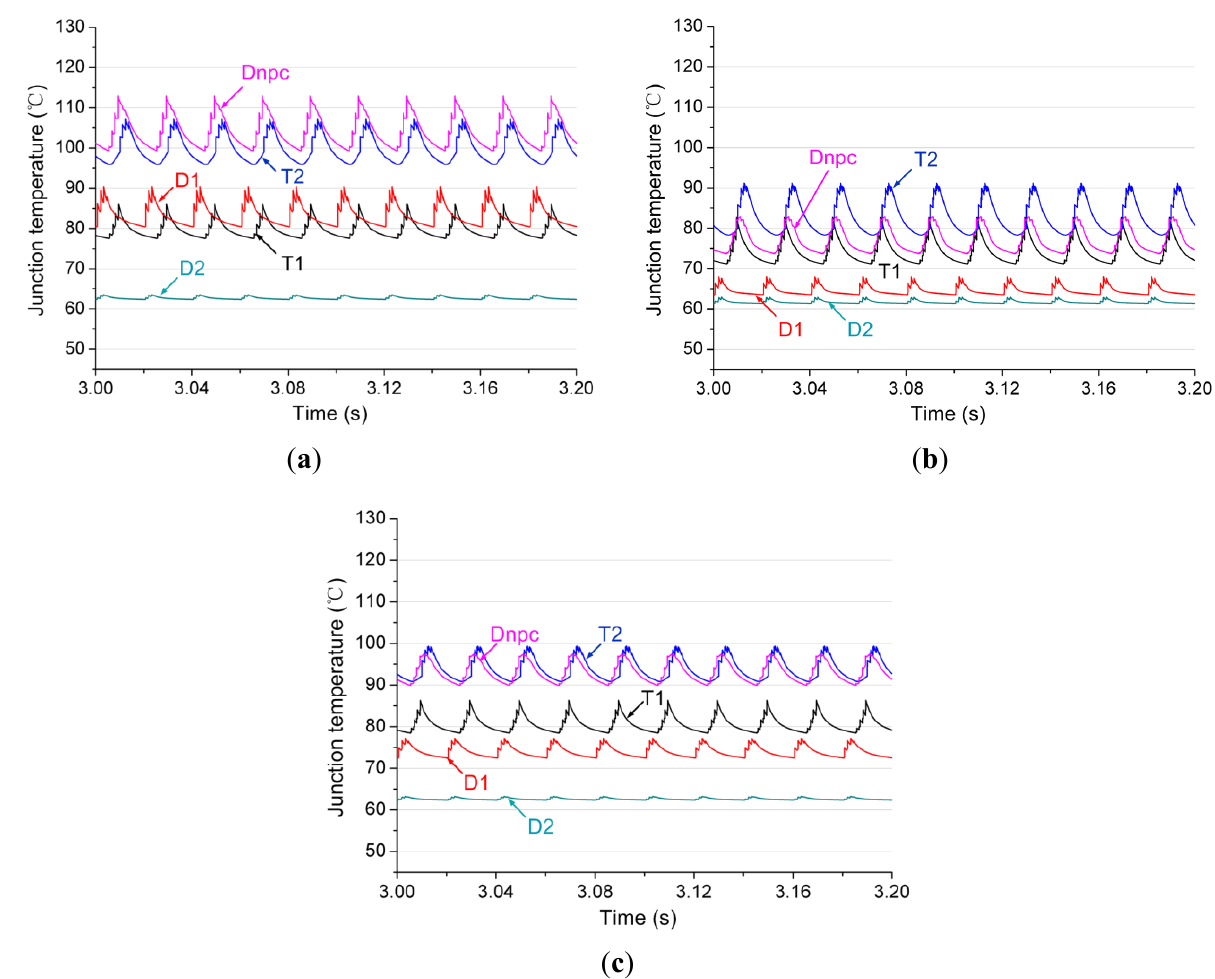
Figure 15. Thermal cycling of the 3L-NPC inverter with different switching device solutions during Low-Voltage-Ride-Through operation condition in Figure 13. ( a ) IGCT presspack solution; ( b ) IGBT presspack solution and ( c ) IGBT module solution.